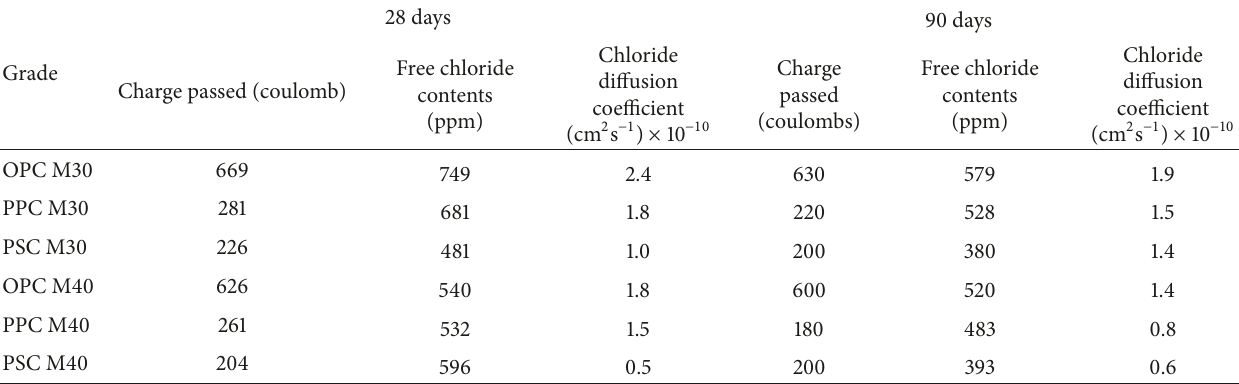
Table 5: Rapid chloride permeability test (RCPT) parameters for OPC, PPC, and PSC M30 and M40 grade concrete types.